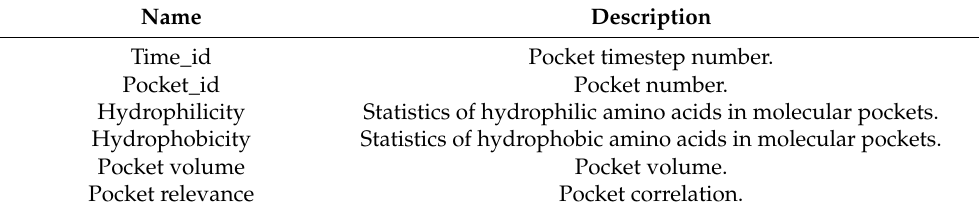
Table 1. Molecular pocket navigation view field description